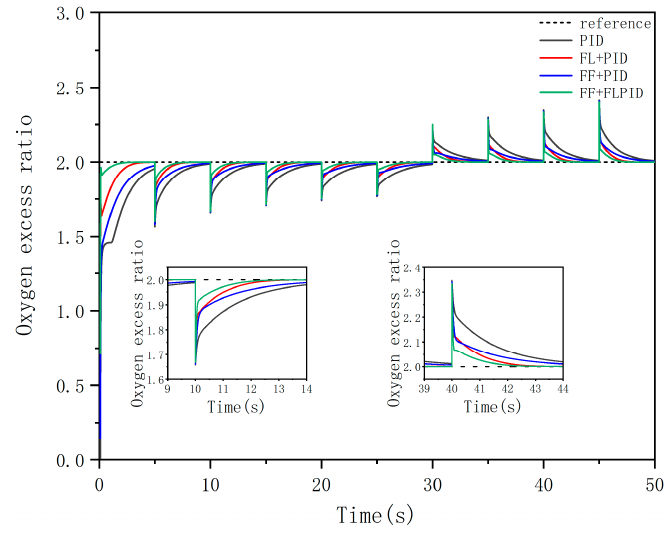
Figure 13. Response of oxygen excess ratio for different control strategies.